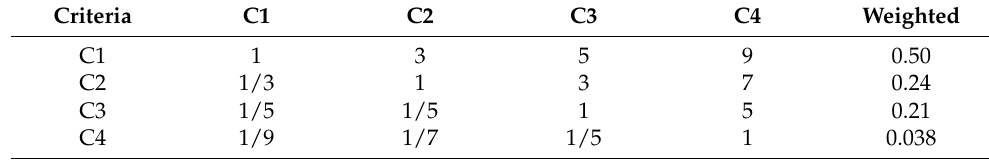
Table 8. The adopted decision criteria for wind plant comparison matrix.